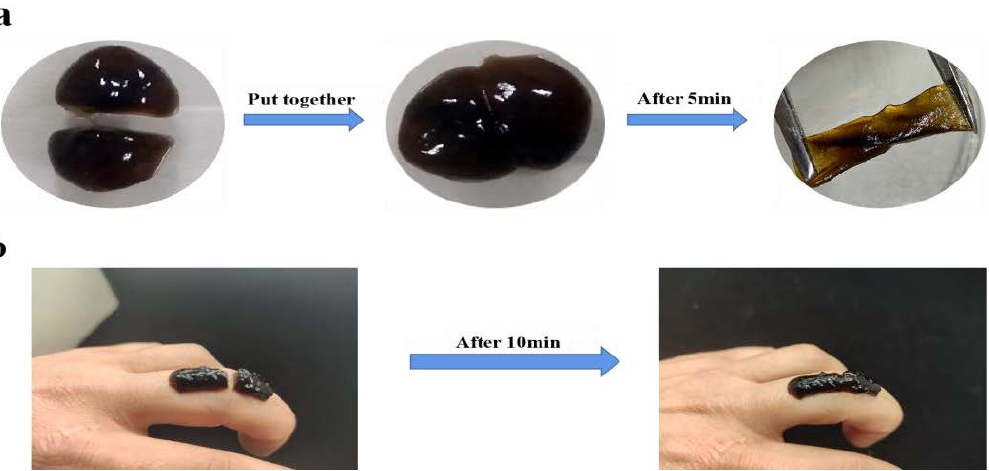
Figure 4. Self − healing test of Gel − PDA+GG+CNC hydrogel. ( a ) Stretchable self − healed hydrogel, ( b ) unbreakable self − healing on the finger. ( b ) unbreakable self − healing on the